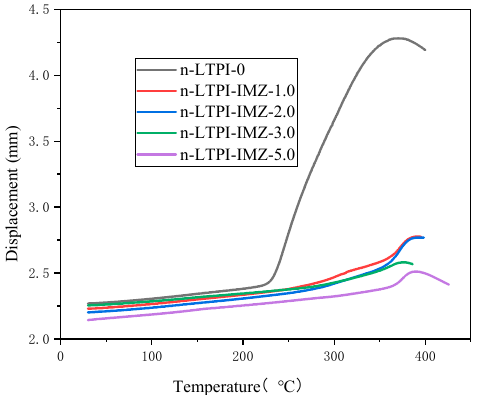
Polymers 2023 , 15 , x FOR PEER REVIEW Figure 8. TMA of the 230 °C/2 h cured n-LTPI films with different IMZ loadings. Figure 8. TMA of the 230 ◦ C/2 h cured n-LTPI films with different IMZ loadings.